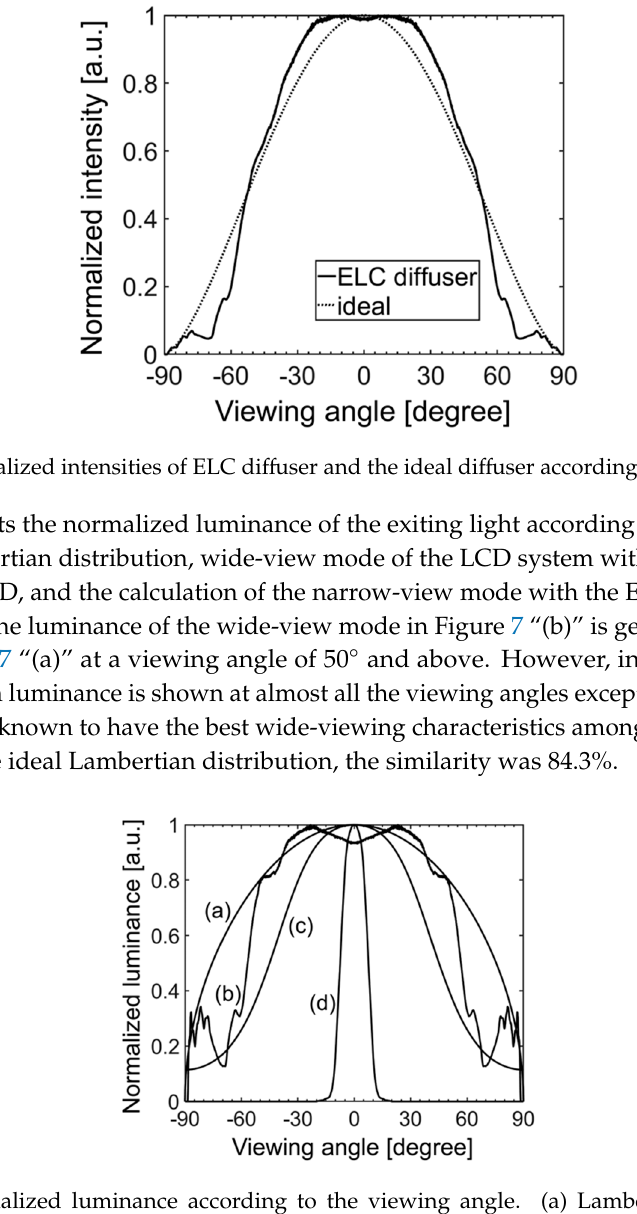
Figure 6. Normalized intensities of ELC diffuser and the ideal diffuser according to viewing angle.